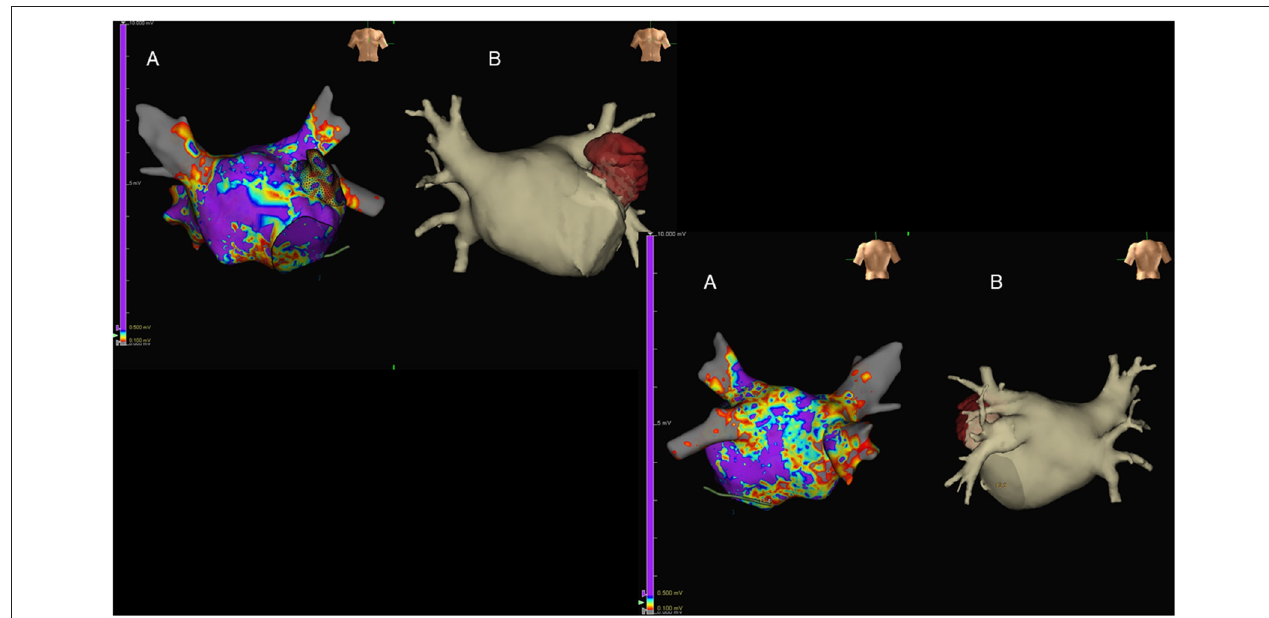
FIGURE 7 | Antero-posterior (upper-left images) and postero-anterior (lower-right images) views of the left atrium (LA) in a patient with long-lasting atrial fibrillation submitted to endocavitary ablation. Three-dimensional (3D) LA anatomy was built by means of EAM [ (A) ; Ensite Precision, St. Jude Medical, USA], aided by volume-rendered CT coronary angiography (CTCA) images (B) . Of note, LA voltage maps were superimposed on the reconstructed 3D LA volume, showing widespread LA disease with diffusely reduced voltages